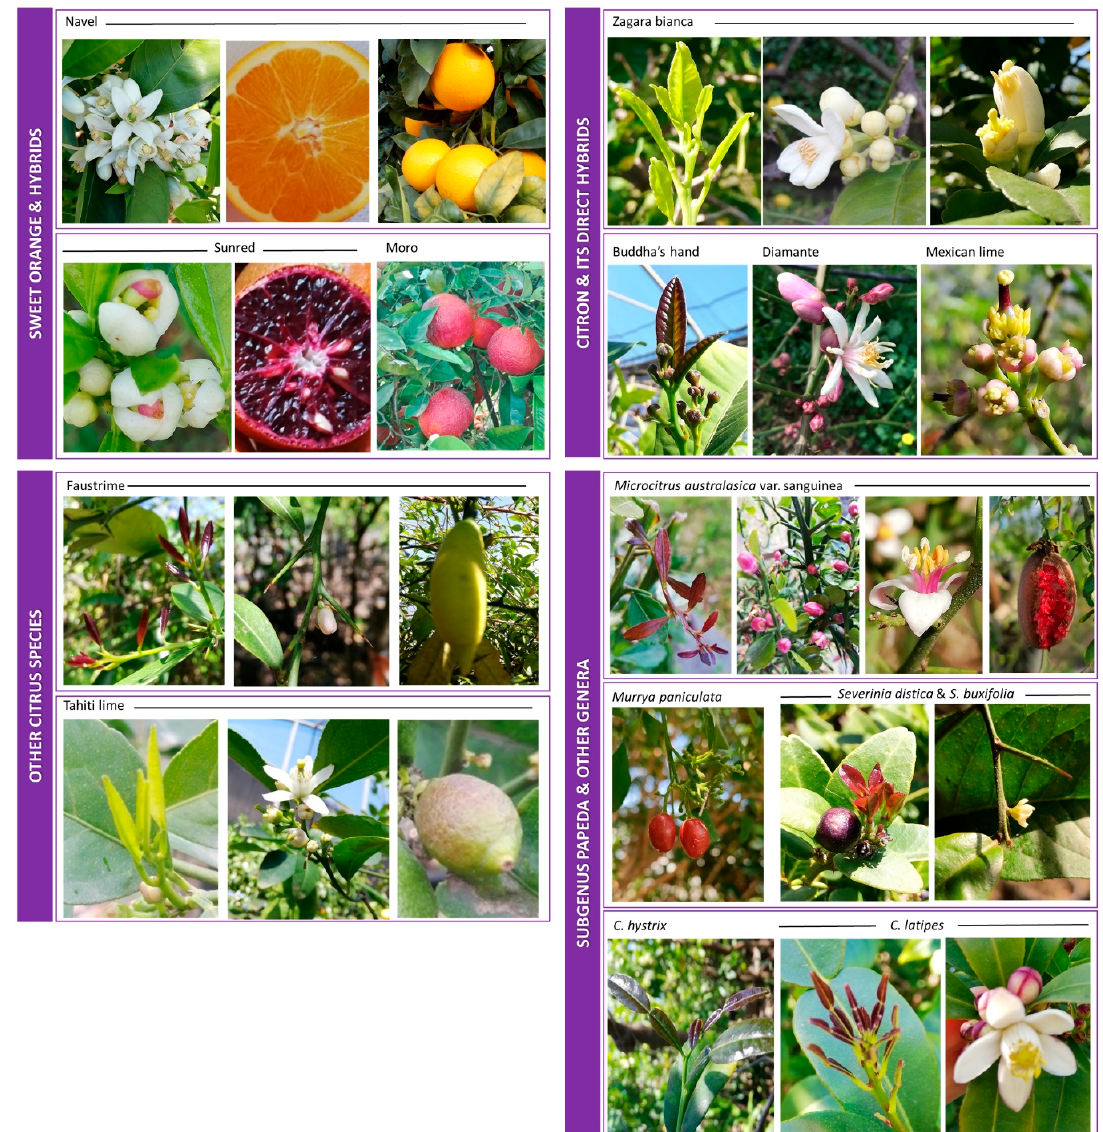
Figure 1. Variability in the levels of anthocyanins in the tissues of the accessions used in this